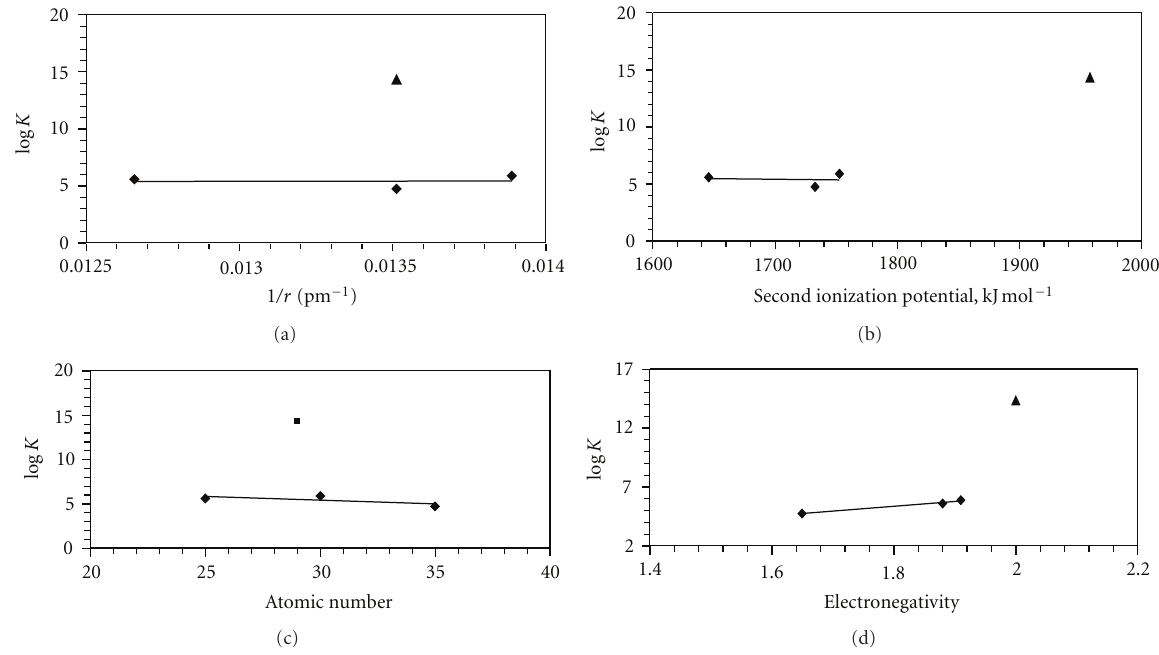
Figure 2: E ff ect of metal ion properties on the stability constants of metal complexes.